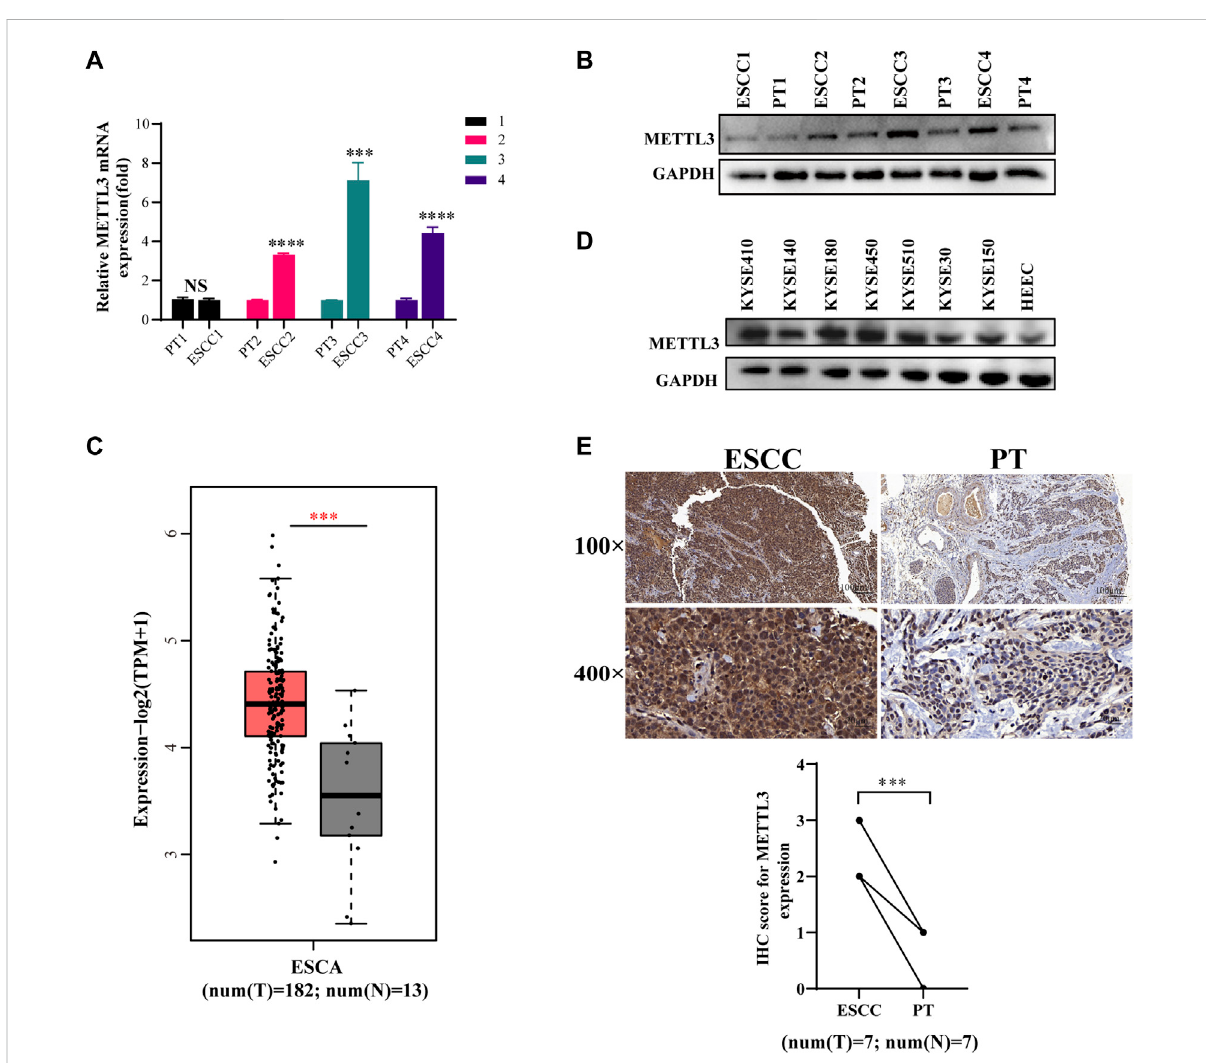
FIGURE 1 METTL3 is upregulated in esophageal squamous cell carcinoma (A,B) . qPCR and WB were used to measure METTL3 expression in 4 pairs of ESCC tissues and corresponding adjacent tissues. (C) . METTL3 expression levels in the TCGA database. (D) . METTL3 was expressed in seven ESCC cell lines and HEEC cells. (E) . Representative image of immunohistochemical staining by METTL3 in 100- fold (scaled bar = 100 μ m) and 400-fold (scaled bar = 20 μ m) magni fi ed ESCC tissues and paired normal tissues in human samples (above). Immunohistochemical expression of METTL3 in ESCC tumor tissue and paired paracancerous tissues (PT) was quantitatively analyzed using ImageJ Pro fi ler software ( n = 7). n.s, no statistical signi fi cance, *** p < 0.001, **** p <